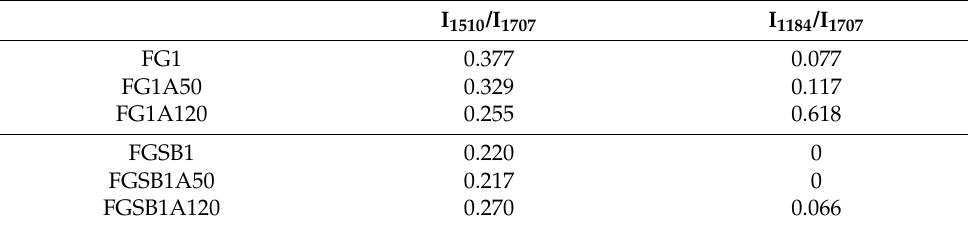
Figure 3. An example of a deconvoluted spectrum of FG1 within the wavelength of 1500–1800 cm − 1 ( a ); and 1000–1300 cm − 1 ( b ). Table 3. Intensity ratio of furan bismaleimide DA peaks.